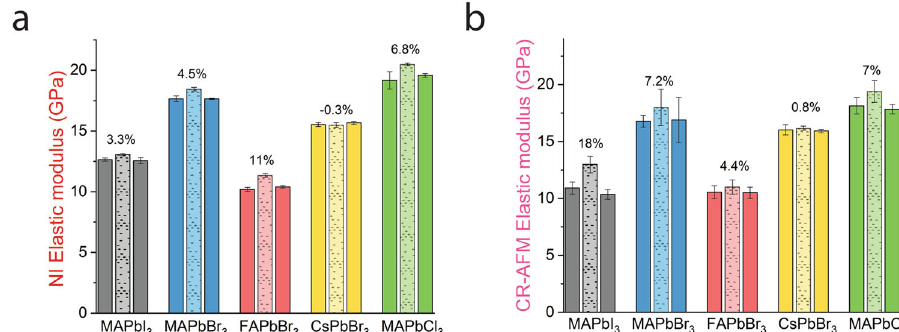
Fig. 2 Elastic modulus results. In each triplet the solid bars represent measurements performed in the dry state (RH ≤ 10%), left for before and right for after measurements represented by the dotted (middle) bars which were performed in the humid state (RH 55 – 60%). The percentage values represent difference between dry and humid states for each set. a Data obtained from NI measurements over 300 – 800 nm depth; b Near-surface elastic moduli, measured at <10 nm depth by CR-AFM. Error bars represent standard deviation of the measurements.